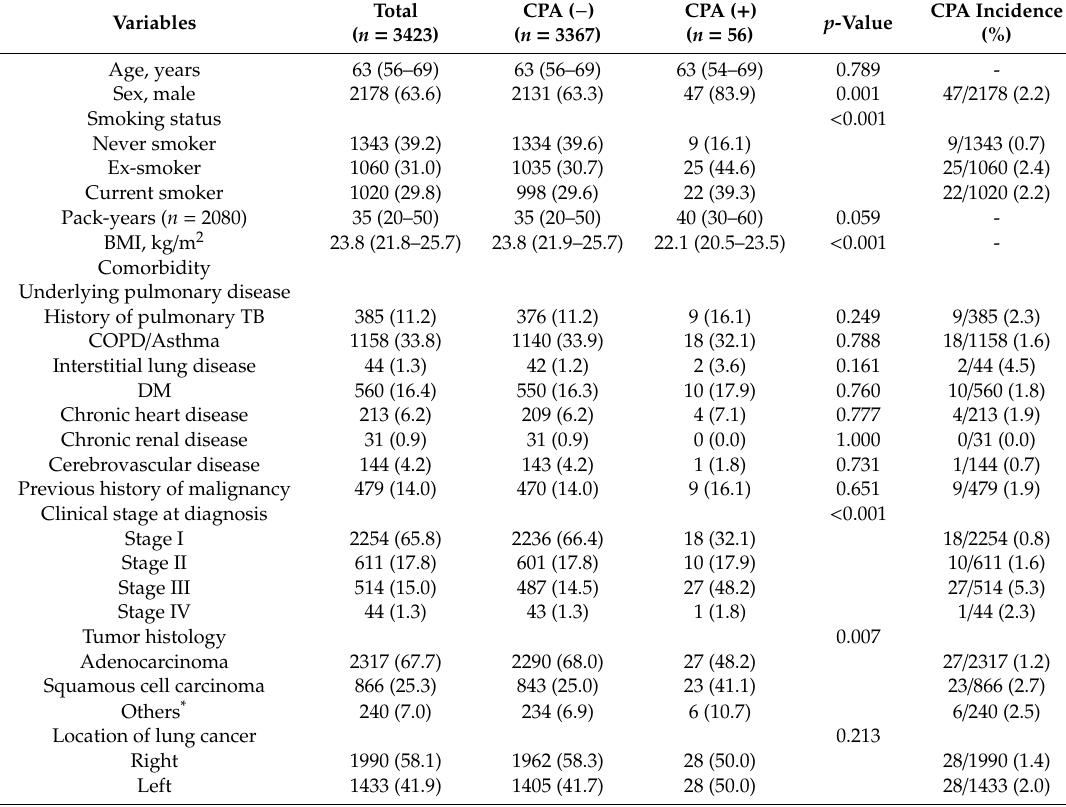
Table 1. Baseline characteristics of patients with NSCLC and the development of chronic pulmonary aspergillosis after lung resection.